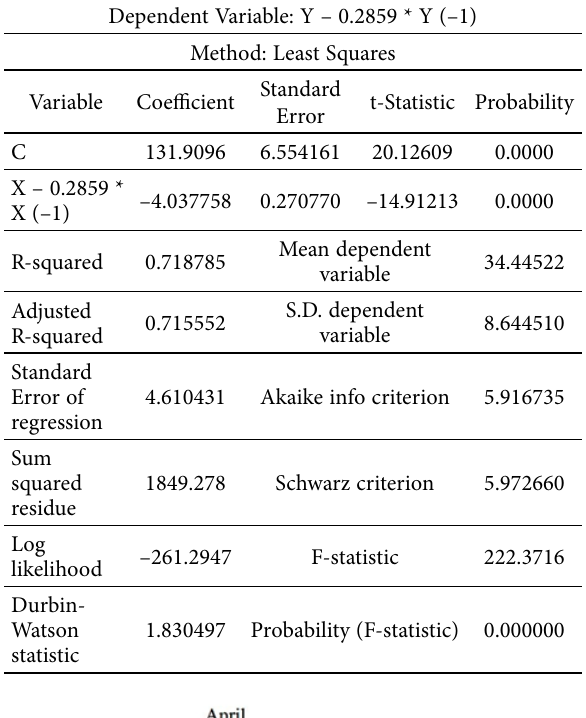
Table 3. Autocorrelation processing of the regression model of air T and RH in the six green belts